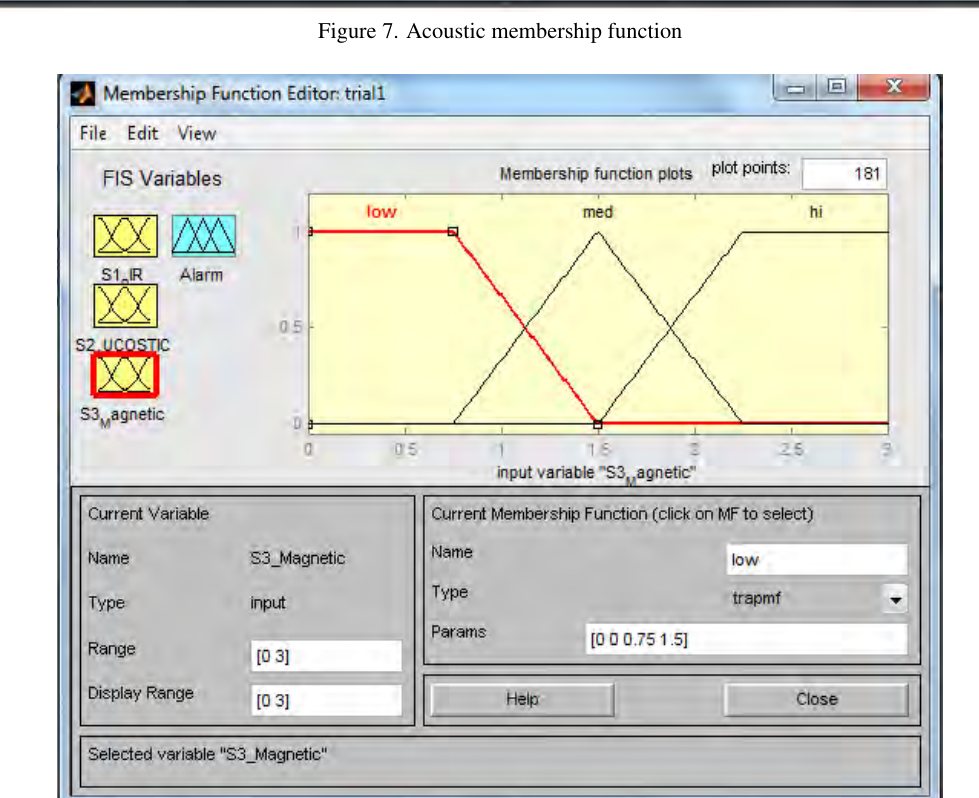
Figure 8. Magnetic membership